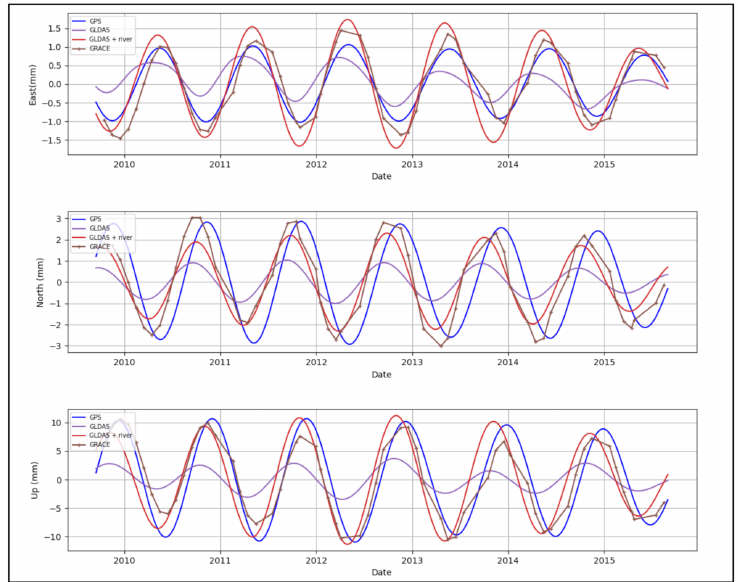
Figure 7. Same as Figure 6 for SAGA (S ã o Gabriel da Cachoeira,